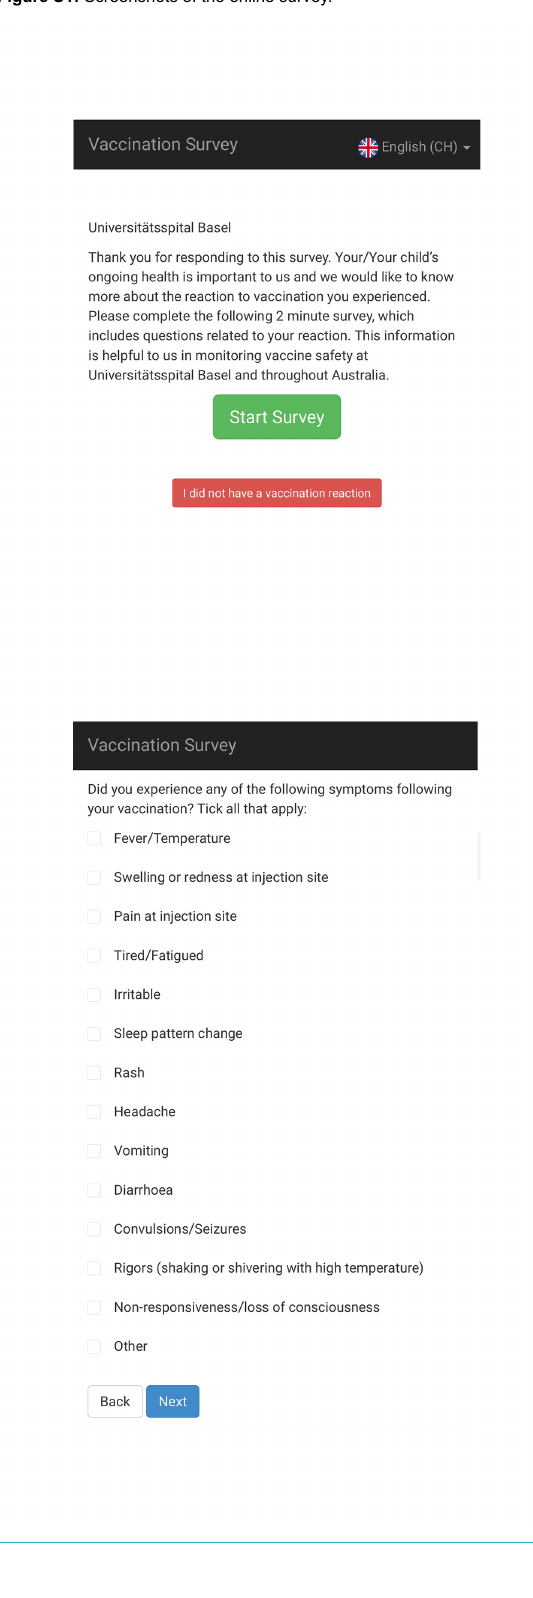
Figure S1: Screenshots of the online